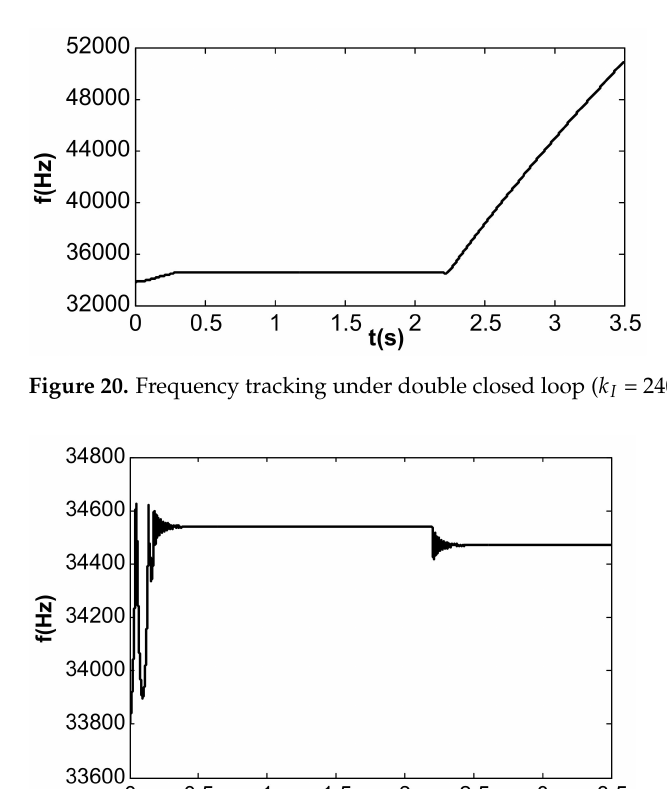
Figure 19. Vibration amplitude when the frequency met the requirements ( k I = 240, k II = 2).